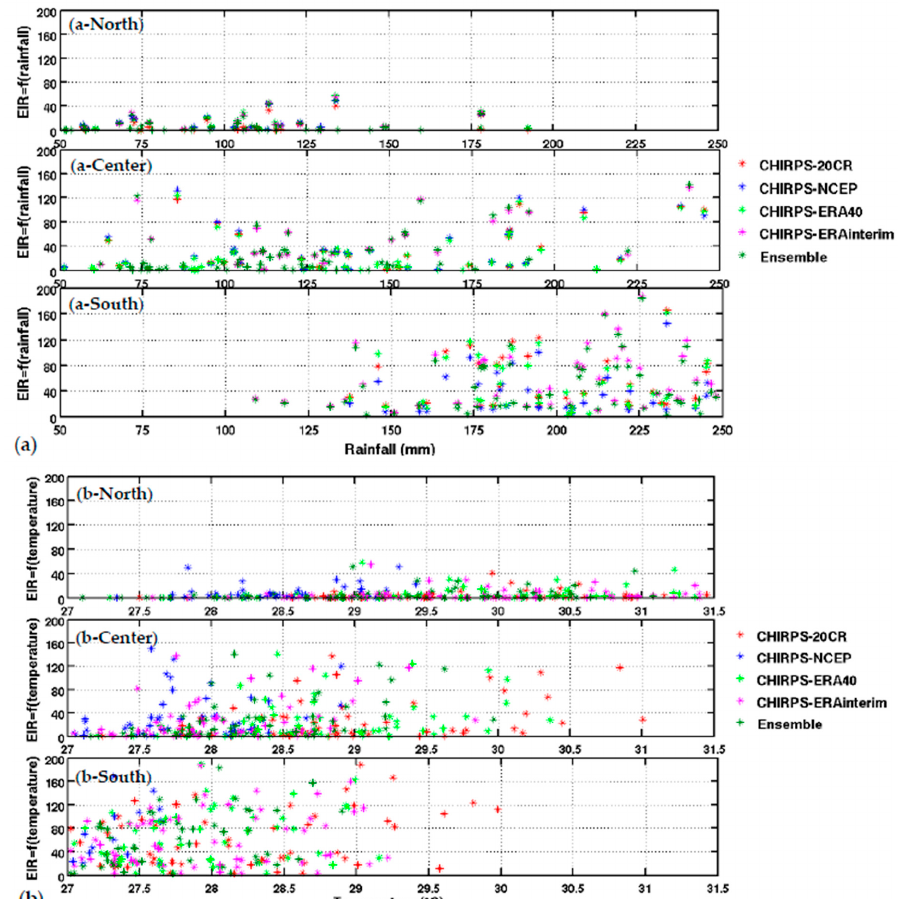
Figure 4. Upper panel: ( a ) variation of EIR as a function of rainfall by averaged Senegal zones (North, central, and South. Lower panel: ( b ) variation of EIR as a function of temperature by averaged Senegal zones (North, central, and South). The rainfall is from CHIRPS, and the temperature is derived from different reanalysis data. Simulated EIR are shown for the common period 1981–2001.